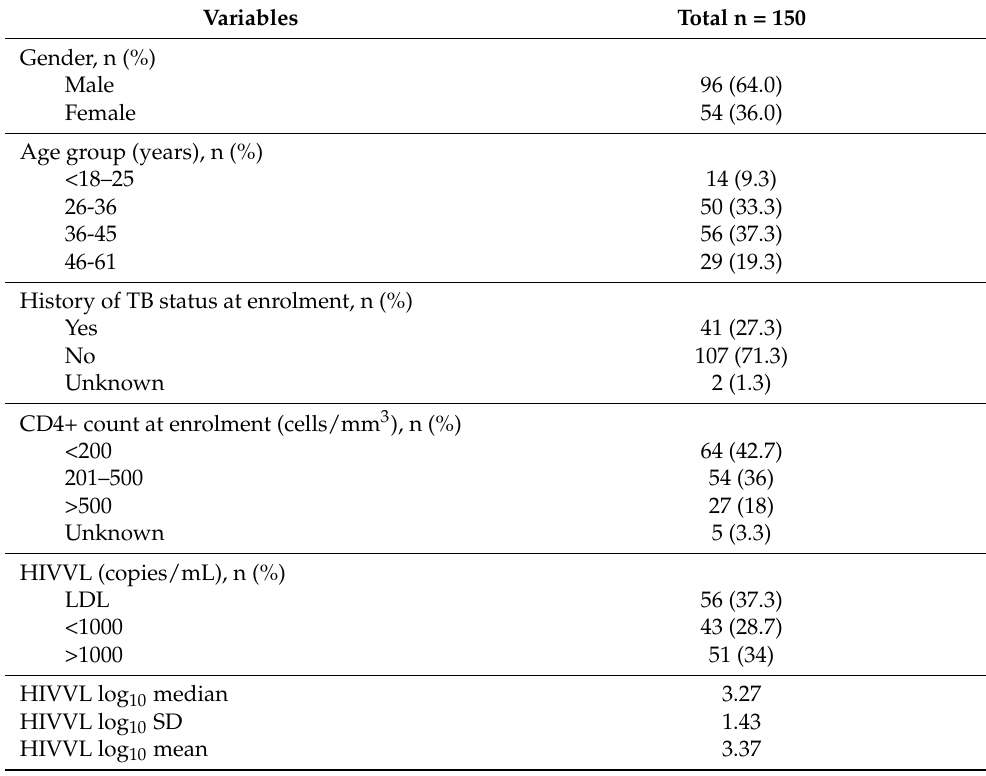
Table 1. Demographic and clinical characteristics of participants at study enrolment. Variables Total n =